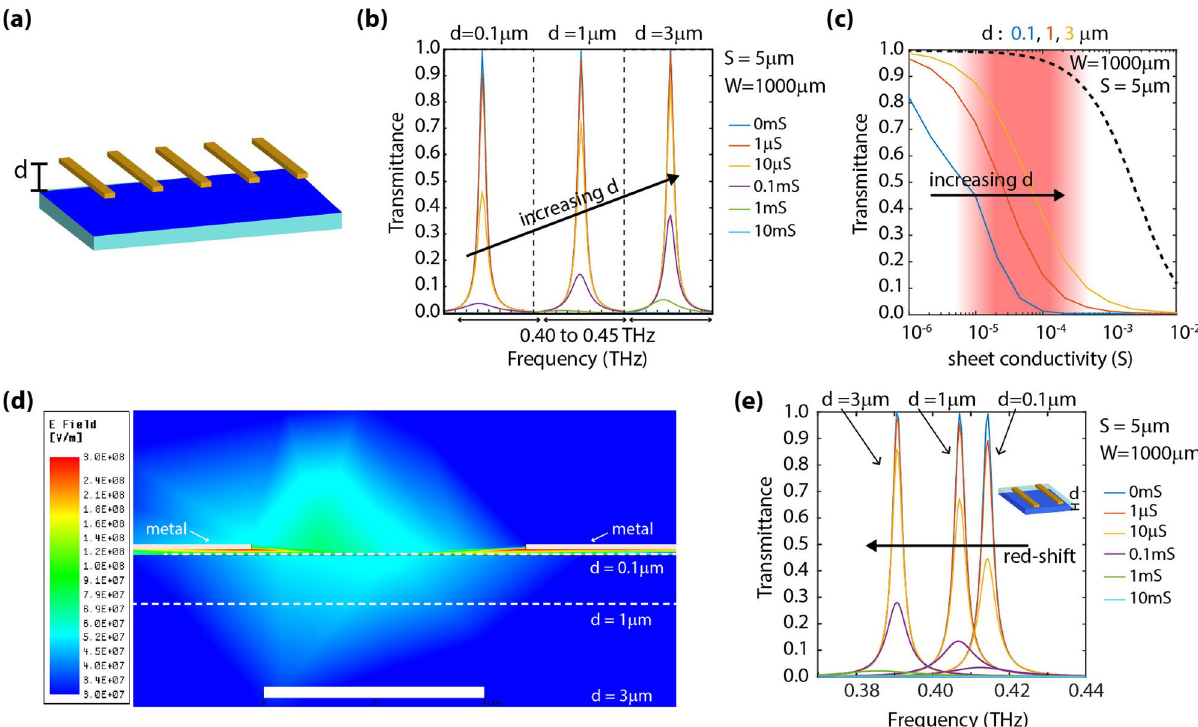
Figure 4. Effect of spacing between the grating and conductive layer. ( a ) Illustration of the analyzed geometry. We vary the spacing, d, between the grating and structure under test in our simulations. (image created in Adobe Illustrator v25.0.1, https ://www.adobe .com/produ cts/illus trato r.html). ( b ) Transmittance spectra (when varying sheet conductivity) for d = 0.1, 1, and 3 µm. ( c ) Transmittance (at resonance, i.e., ~ 0.42 THz) versus sheet conductivity. The dashed black curve corresponds to the case depicted in Fig. 1b, colored continuous curves correspond to d = 0.1, 1, and 3 µm, respectively. Increasing d shifts the characteristic curves towards higher conductivity levels. ( d ) Simulated field distribution (at resonance) in the gap of the structure. The white scale bar represents 4 µm. ( e ) Assuming a polyimide spacer (light blue layer) between the grating and conductive layer, transmittance spectra (when varying sheet conductivity) for d = 0.1, 1, and 3 µm. A redshift is observed in the position of the resonance as d is increased.